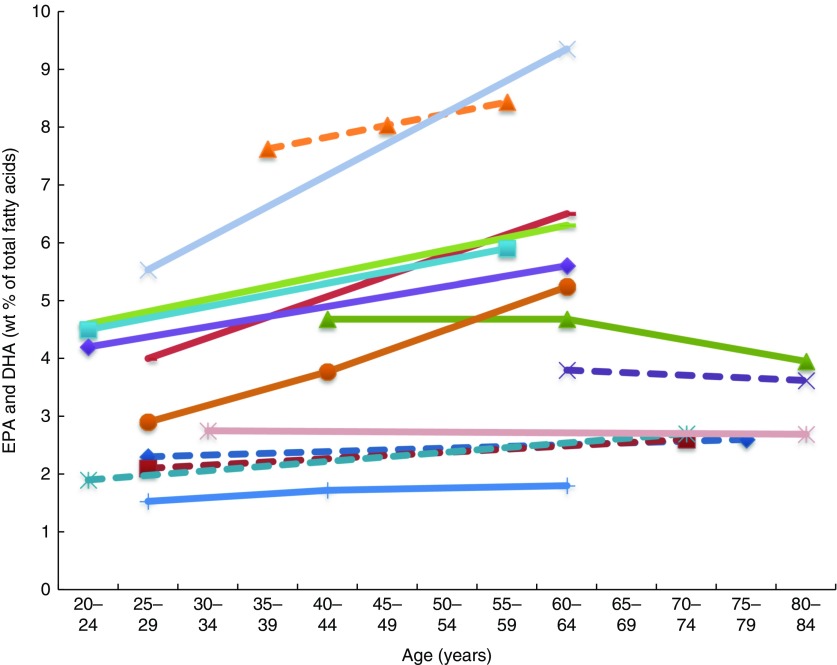
Plasma EPA levels and DHA (wt% of total fatty acids) of different age groups from studies reviewed in this systematic literature review. Each line represents a different study (population) and each symbol on a line represents an age group. Full line = significant difference between age groups measured in that study. Broken line = no significant difference between age groups measured in that study. , Plourde et al.(

43

) NS; , Vandal et al.(

42

) NS; , Sfar et al. (women)(

54

); , Sfar et al. (men)(

54

) NS; , Fortier et al.(

40

) NS; , Dewailly et al.(

58

); , Dewailly et al.(

59

); , Rees et al. g1(

41

); , Rees et al. g2(

41

); , Rees et al. g3(

41

); , Rees et al. g4(

41

); , Kuriki et al.(

46

) NS; , Dewailly et al.(

61

); , Babin et al.(

57

) NS.